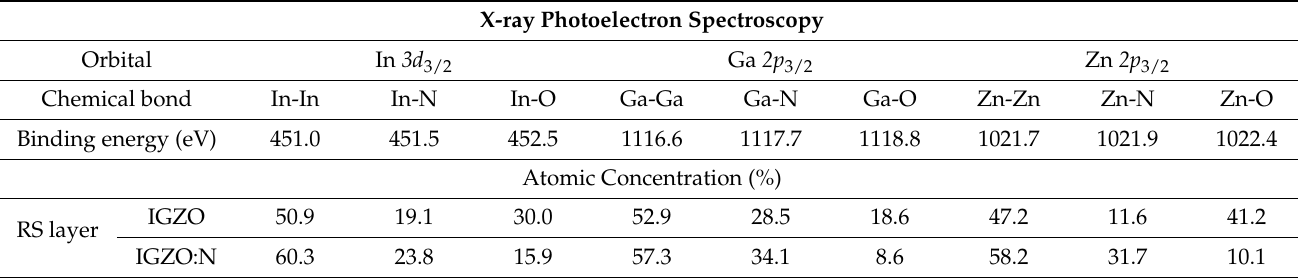
Table 1. XPS binding energy values and atomic concentrations for each metal species in IGZO and IGZO:N nanocomposites.